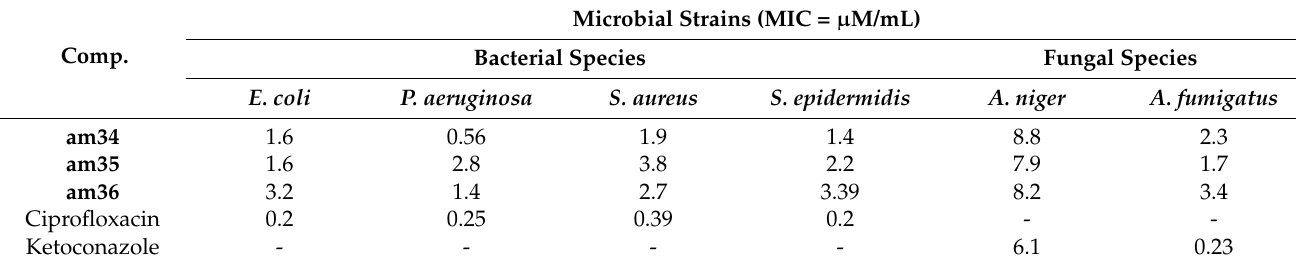
Table 15. Results of antimicrobial screening of the synthesized compounds (am34 – am36 ).